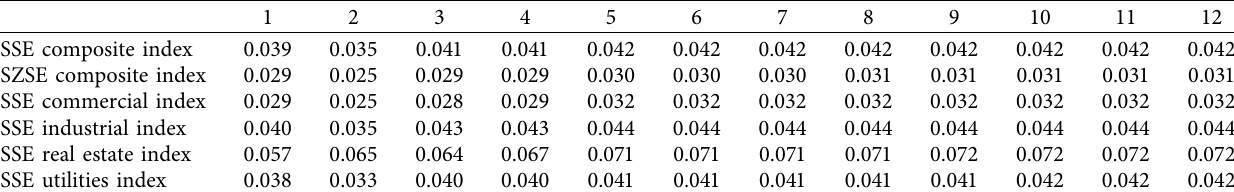
Table 2: Forecast error variance decomposition of stock volatility return to EPU.